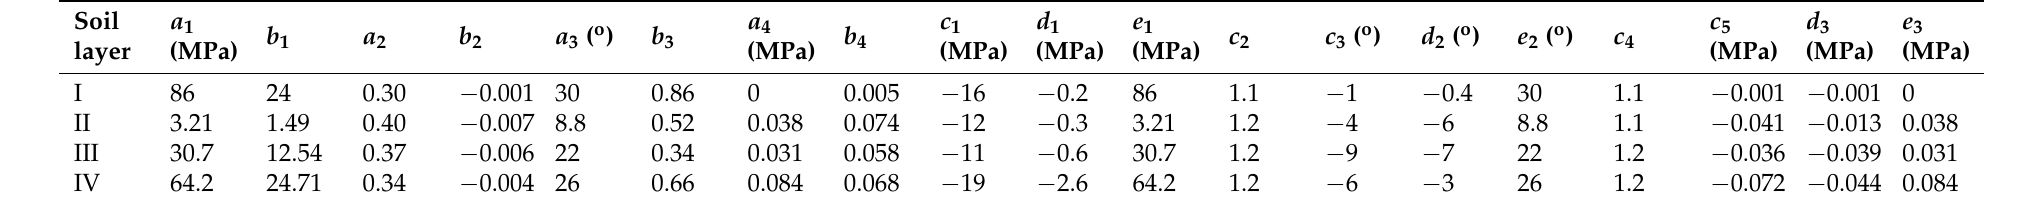
Table 3. Mechanical parameters of the soil